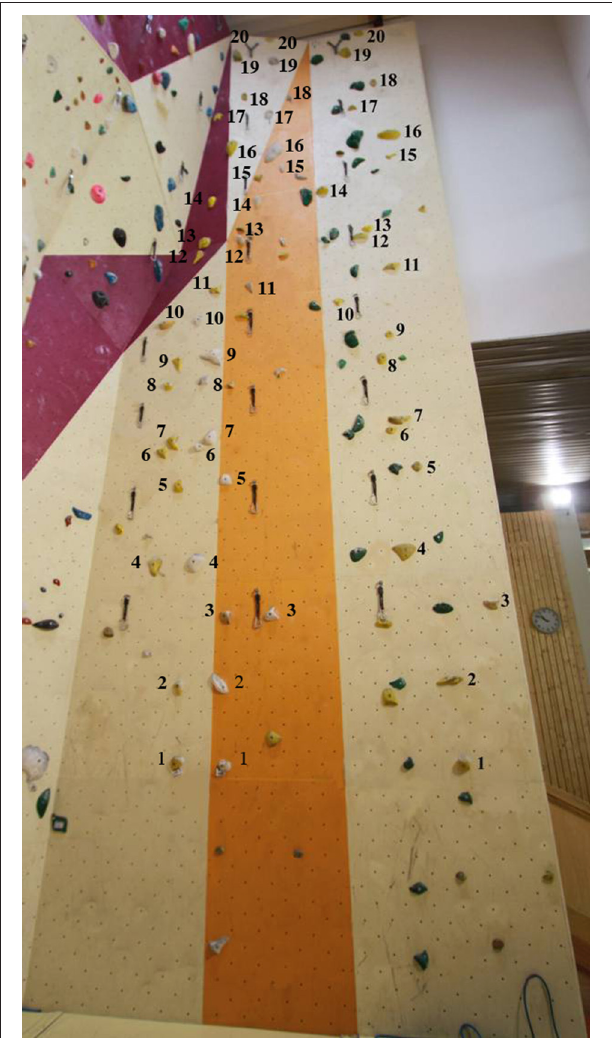
FIGURE 1 | Location of the 20 hand-holds for the three routes. Adapted from Seifert et al. (2015).